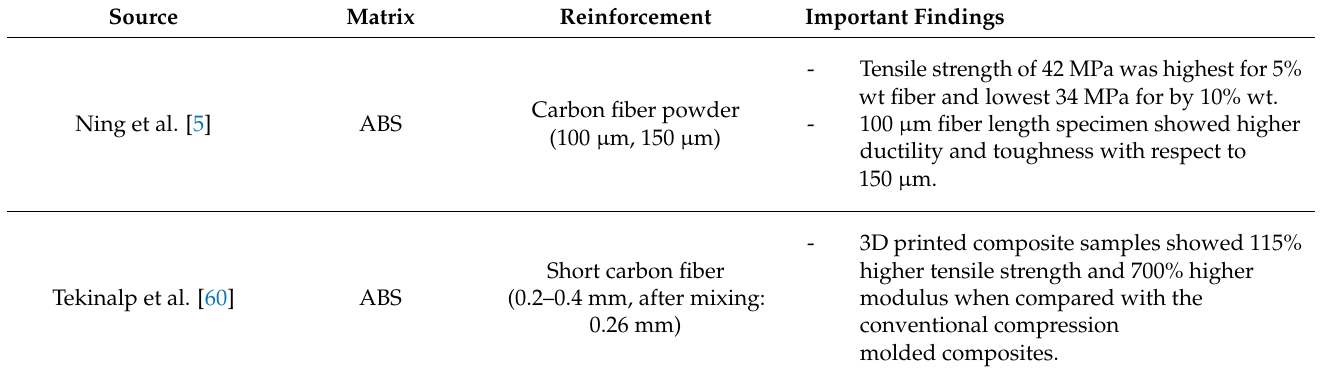
Table 3. Summary of the literature on short fiber